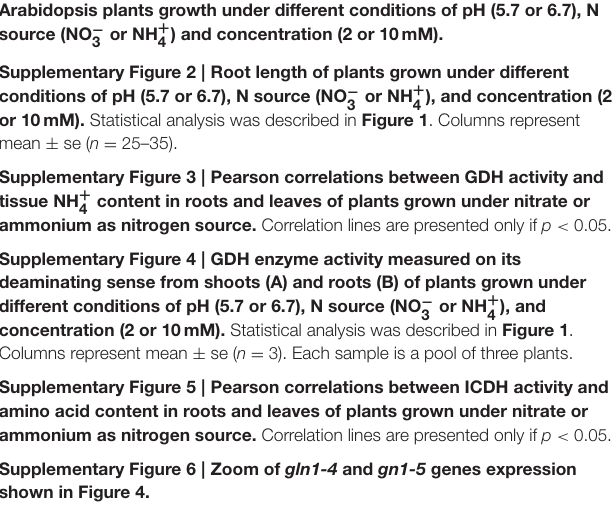
Supplementary Figure 1 | External medium pH monitoring during Arabidopsis plants growth under different conditions of pH (5.7 or 6.7), N source (NO − 3 or NH + 4 ) and concentration (2 or 10mM). Supplementary Figure 2 | Root length of plants grown under different conditions of pH (5.7 or 6.7), N source (NO − 3 or NH + 4 ), and concentration (2 or 10mM). Statistical analysis was described in Figure 1 . Columns represent mean ± se ( n = 25 –35). Supplementary Figure 3 | Pearson correlations between GDH activity and tissue NH + 4 content in roots and leaves of plants grown under nitrate or ammonium as nitrogen source. Correlation lines are presented only if p < 0.05 . Supplementary Figure 4 | GDH enzyme activity measured on its deaminating sense from shoots (A) and roots (B) of plants grown under different conditions of pH (5.7 or 6.7), N source (NO − 3 or NH + 4 ), and concentration (2 or 10mM). Statistical analysis was described in Figure 1 . Columns represent mean ± se ( n = 3 ). Each sample is a pool of three plants. Supplementary Figure 5 | Pearson correlations between ICDH activity and amino acid content in roots and leaves of plants grown under nitrate or ammonium as nitrogen source. Correlation lines are presented only if p < 0.05 . Supplementary Figure 6 | Zoom of gln1-4 and gn1-5 genes expression shown in Figure